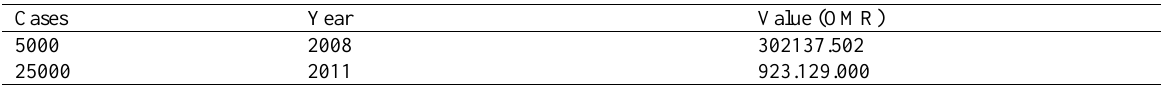
Table 8: Statistics for abroad donation